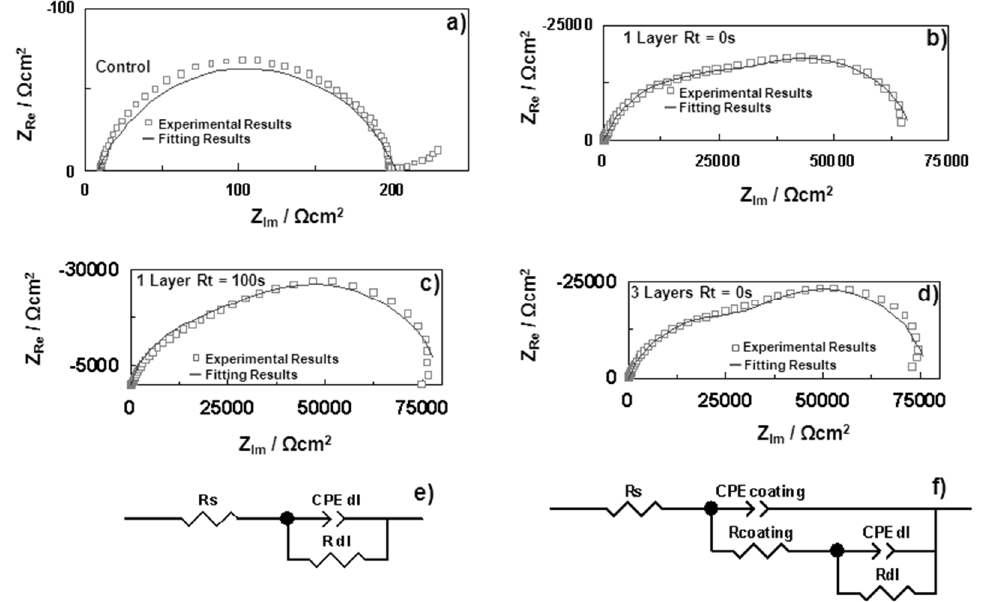
Figure 5. Nyquist plots for: ( a ) Control and coated HDGS samples with one layer deposited by dip coating; ( b ) without residence time ( R t = 0 s) and ( c ) with residence time ( R t = 100 s); ( d ) HDGS samples coated by three consecutive dip steps and R t = 0 s in the instants of exposure to highly alkaline solution. EECs used for numerical fitting of the Nyquist plots for: ( e ) Control and ( f ) coated HDGS samples. Reprinted with permission from Coatings MDPI [204].